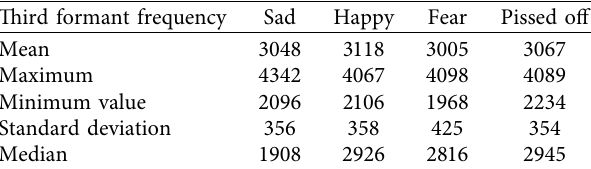
Table 2: Statistical parameters related to different emotions of the third formant.